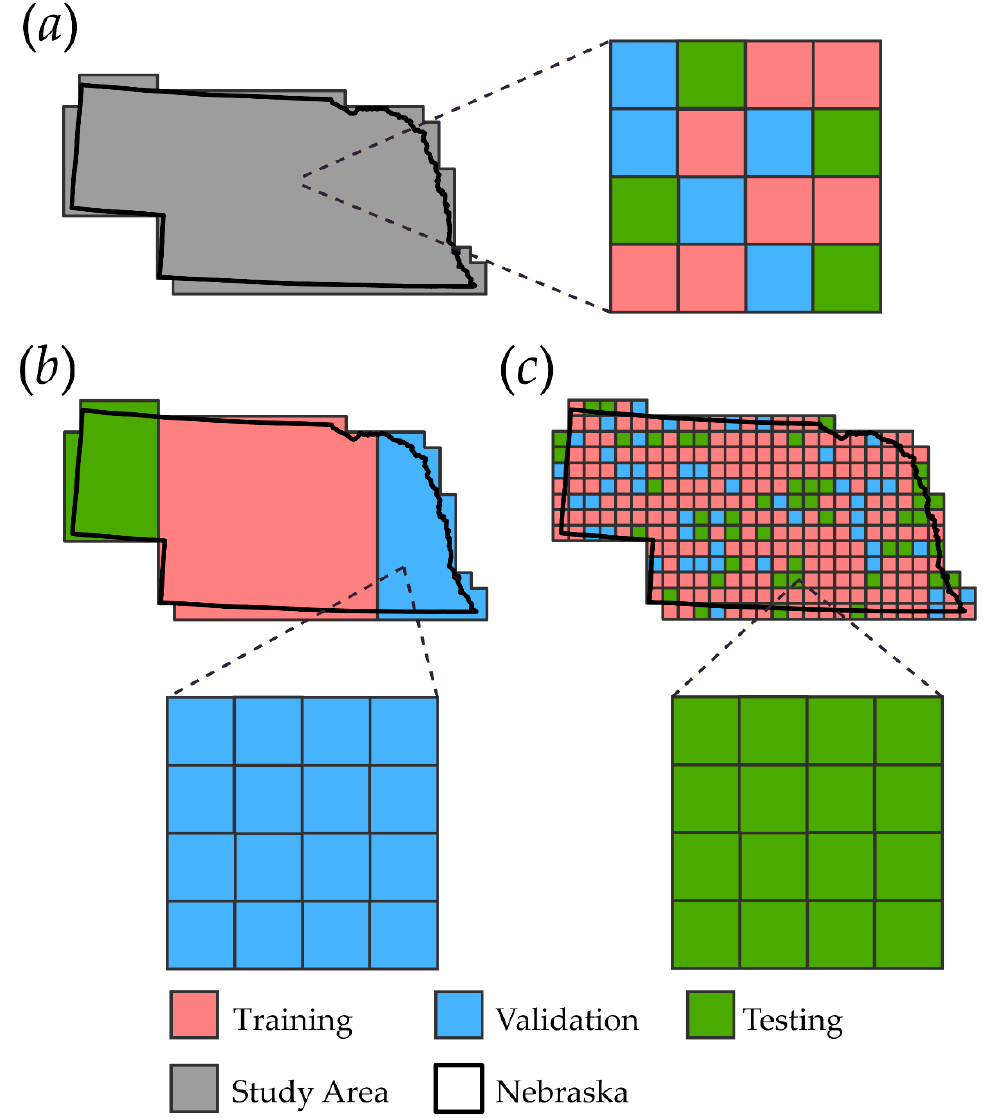
Figure 3. Conceptualization of geospatial sampling options used to generate and partition image chips into training, validation, and testing sets. ( a ) Simple random chip partitioning: entire study area extent is divided into chips, which are then randomly split into training, validation, and testing sets. ( b ) Geographically stratified chip partitioning: stratification using geographically contiguous regions. ( c ) Tessellation stratified random sampling: study area extent is first tessellated and then all chips from the same tessellation unit are subsequently randomly assigned to training, validation, and testing sets.